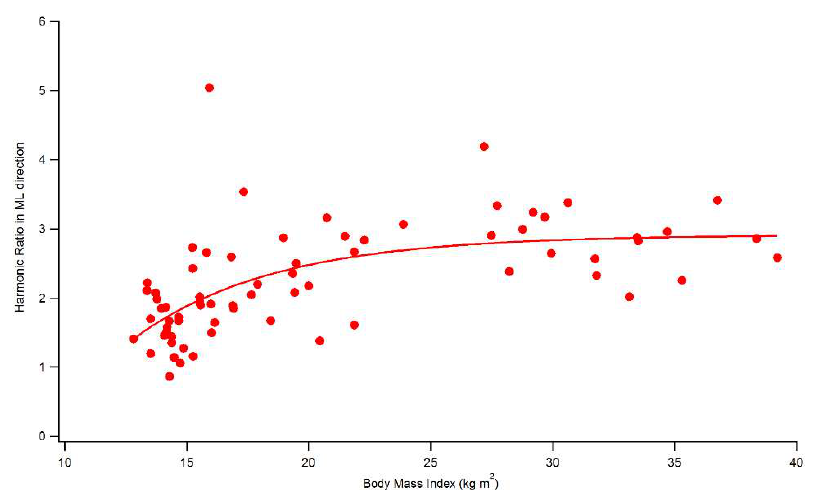
Figure 2. Trend of HR in the ML direction (calculated according to Menz et al., 2003 [26]) with the BMI for all participants.